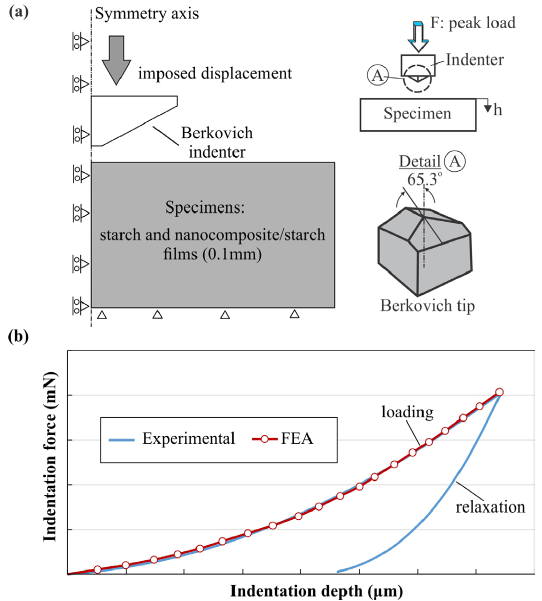
Figure 2. Schematic procedure of (a) the Finite Element Model of the nanoindentation testing simulation and (b) curve-fitting of the nanoindentation measurements by computationally generated indentation